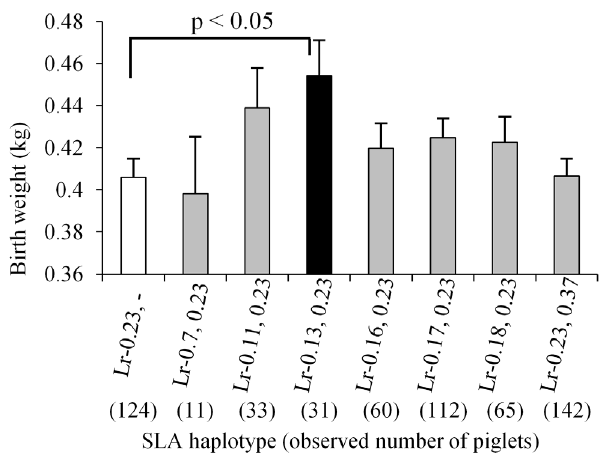
Figure 2. Comparison of birth weights among Lr-0.23 homozygous and heterozygous piglets. Columns and bars indicate means and standard error, respectively. White and black columns represent the lower and higher mean values of Lr-0.23, and Lr-0.13, 0.23, respectively, with significant differences among haplotypes. Gray columns represent mean values that did not differ significantly from those of other